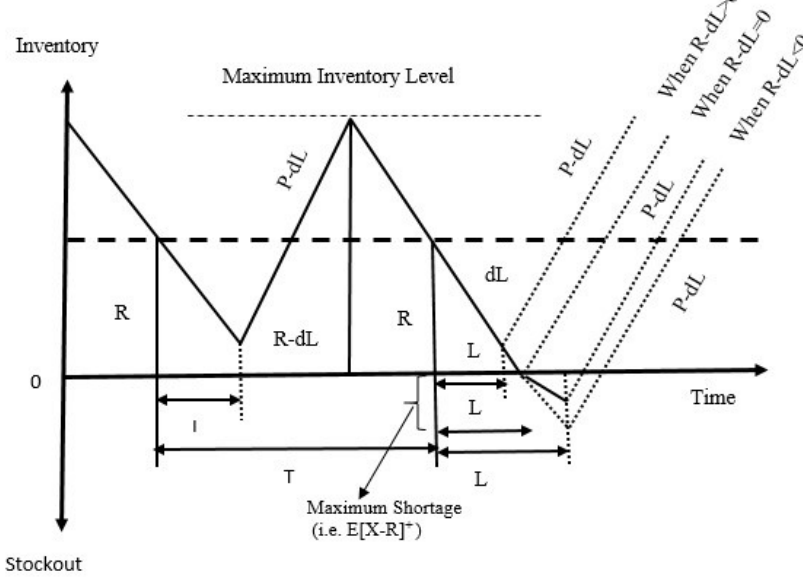
Figure 1. Fuzzy random production-inventory